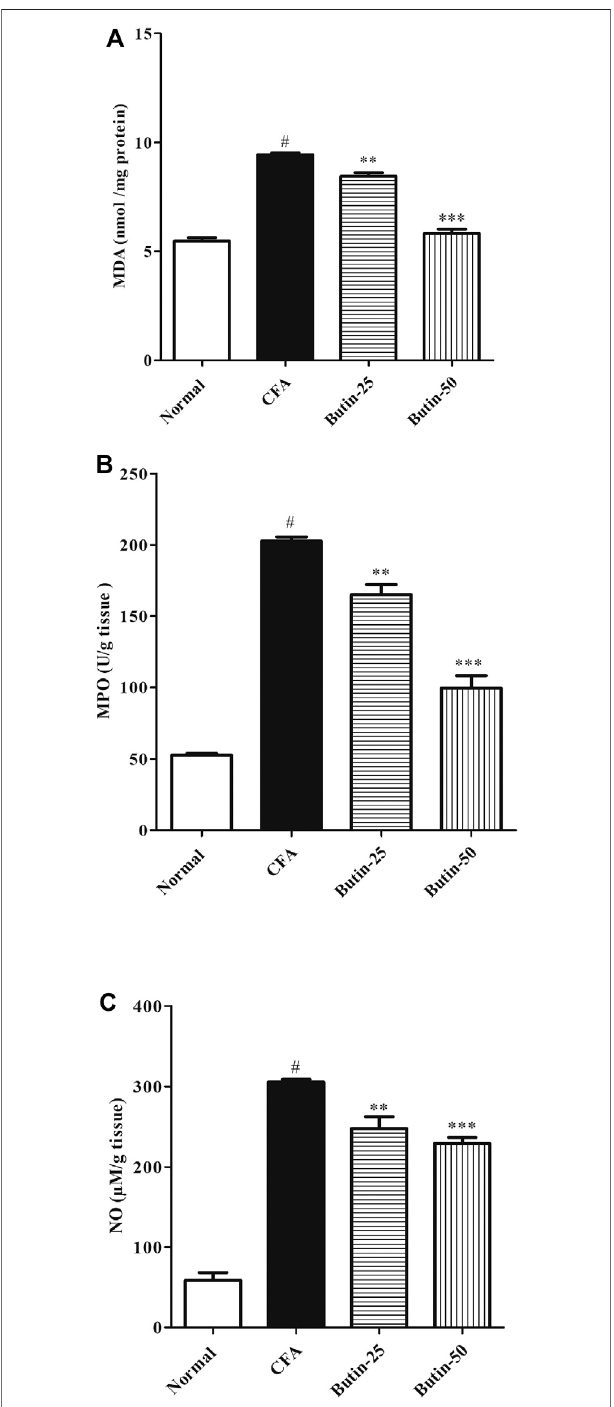
FIGURE 7 | Effect of butin on oxidative and nitrative stress marker levels (A) MDA, (B) MPO, and (C) Nitrate in CFA-treated rats. Values are expressed in mean ± SEM ( n = 6). # p < 0.05 vs. normal control rats and ** p < 0.01 and *** p < 0.001 vs. CFA control rats. One-way ANOVA followed by Tukey ’ s post hoc